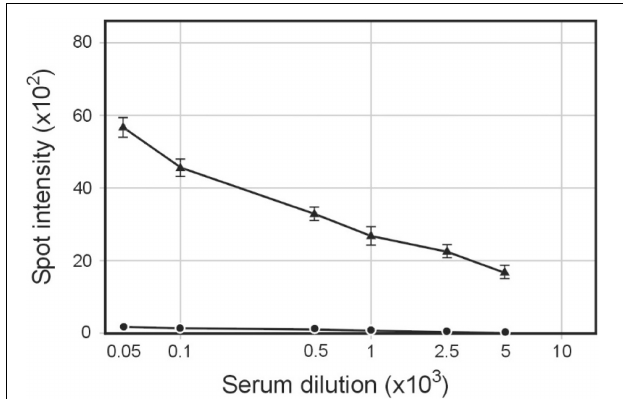
FIGURE 5 | Heterologous expression of non-host proteins in phagemids. Rabbits were immunized with purified pMPMT6:: (cid:56) 6fm phagemid particles grown in S. enterica ser. Typhimurium cells expressing HCV E1. Sera were analyzed by quantitative dot ELISA; 0.1 µ g of commercial HCV E1 protein suspended in PBS was spotted on a nitrocellulose strip and allowed to dry. Titers of IgG polyclonal antibodies were collected on day 28 after immunization. The intensity of the color of each spot was expressed as the change of the spot intensity compared with the negative control where spotting of protein was omitted. For each point, 4 spots were analyzed. Line: